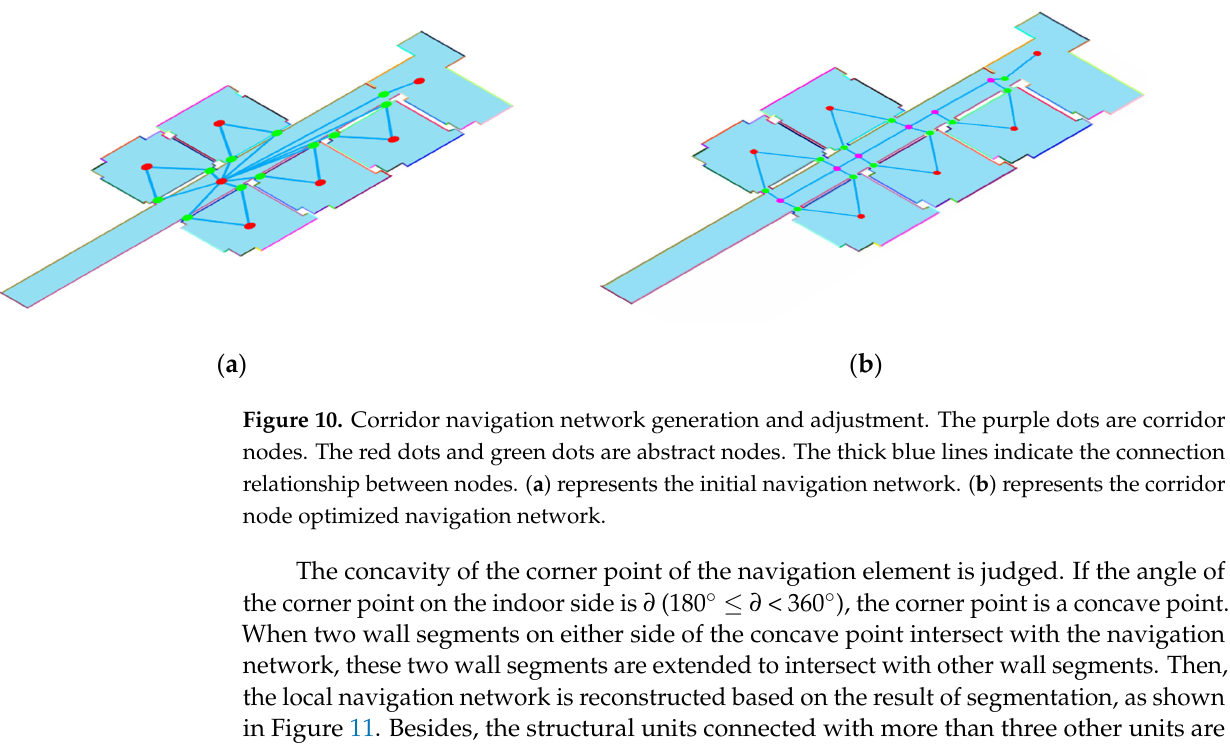
12 of 25 Figure 9. Statistics graph of wall projection raster. ( a ) represents the column statistics graph in step 2 of Figure 8b represents the row statistics graph of the purple boxed area in Figure 8b. The red line indicates the threshold values. ( b ) represents the column statistics graph in step 3 of Figure 8c. After the doors and connection transition spaces are extracted, there are still some “hidden doors” and connection transition spaces that need to be identified. Since some doors are closed during the data collection process, the location of the door may be con- sidered as wall surface in door extraction. Secondly, since point cloud acquired by some laser scanning devices may have local drift. These drifted point clouds will be considered as connecting transition spaces when they appear inside the walls. To solve this problem, the following reasonable rules were made to automatically correct partially undetected doors and incorrectly detected connecting transition spaces. Rule 1 is used to detect “hid- den doors”. Rule 2 is used as an optional rule to remove connection transition areas that are incorrectly constructed due to drifting point cloud.